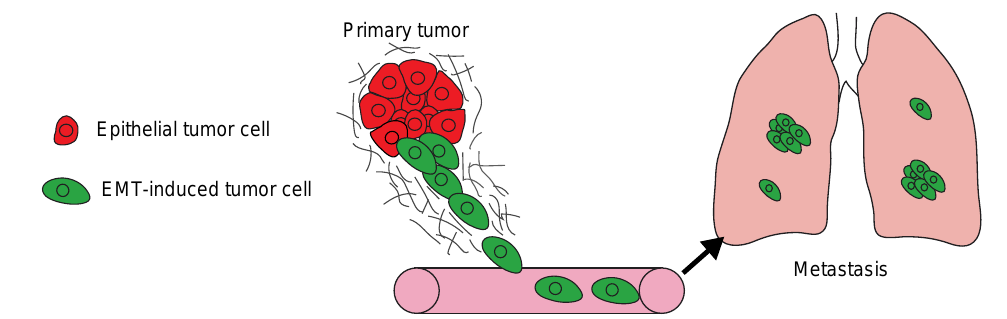
Figure Figure 1. The model summarizes the steps involved in the development of metastasis. Epithelial-to- mesenchymal transition (EMT) program activation in tumor cells (green) promotes local invasion.